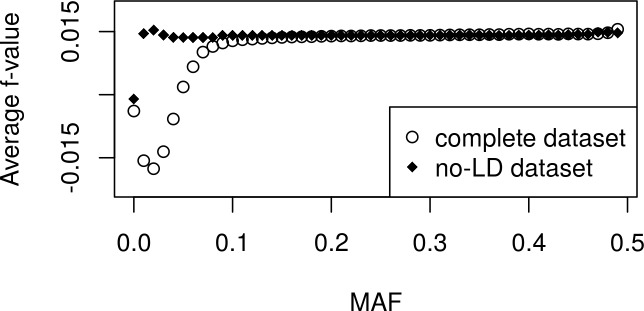
Average f-values.Average f-values corresponding to subsets of markers with MAF value equal or above the value shown in the abscissa axis.